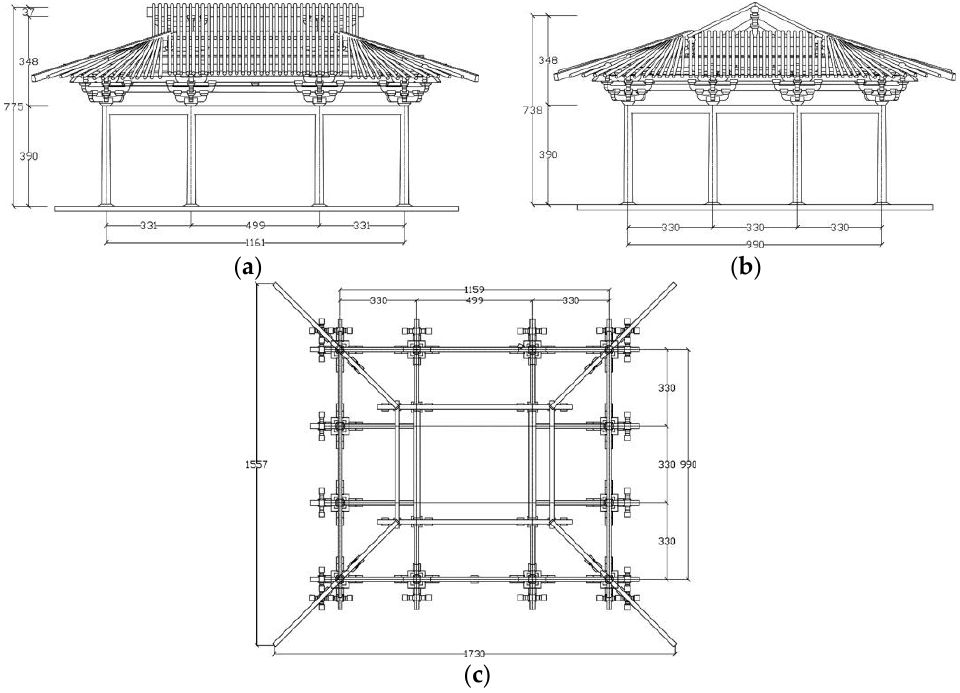
Figure 6. ( a ) Front direction. ( b ) Lateral direction. ( c ) Overhead view of the specimen (unit: